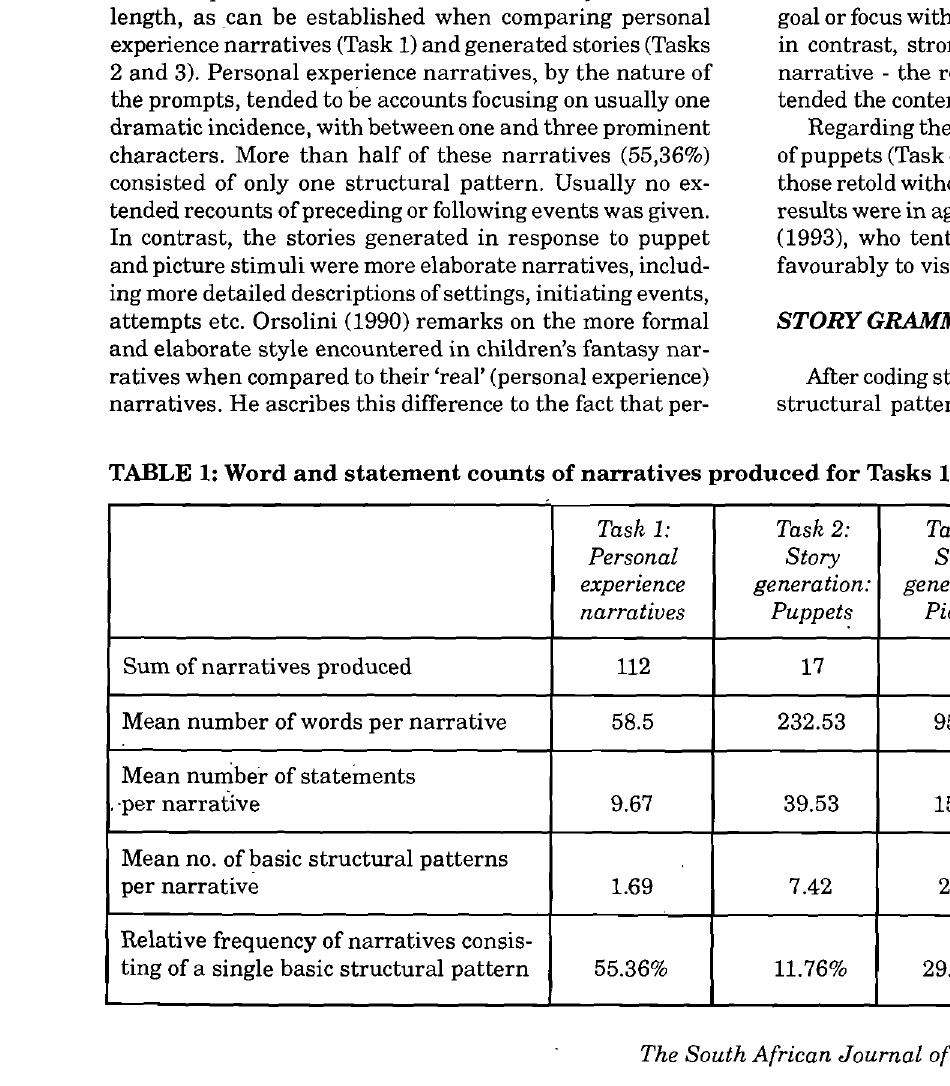
TABLE 1: Word and statement counts of narratives produced for Tasks 1 -